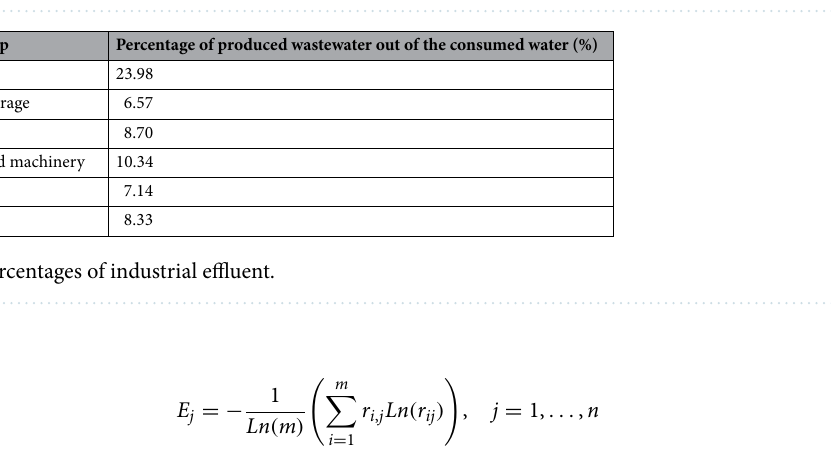
Figure 5. Correlation between production and job opportunities (employment) of the industries.